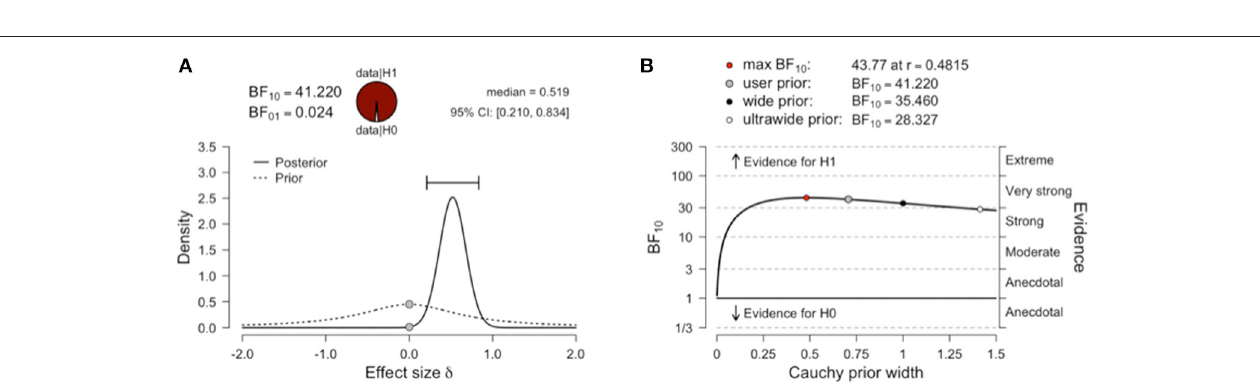
FIGURE 1 | Bayes factor analysis on the Simon difference score. (A) Prior and posterior; (B) Bayes factor robustness check.